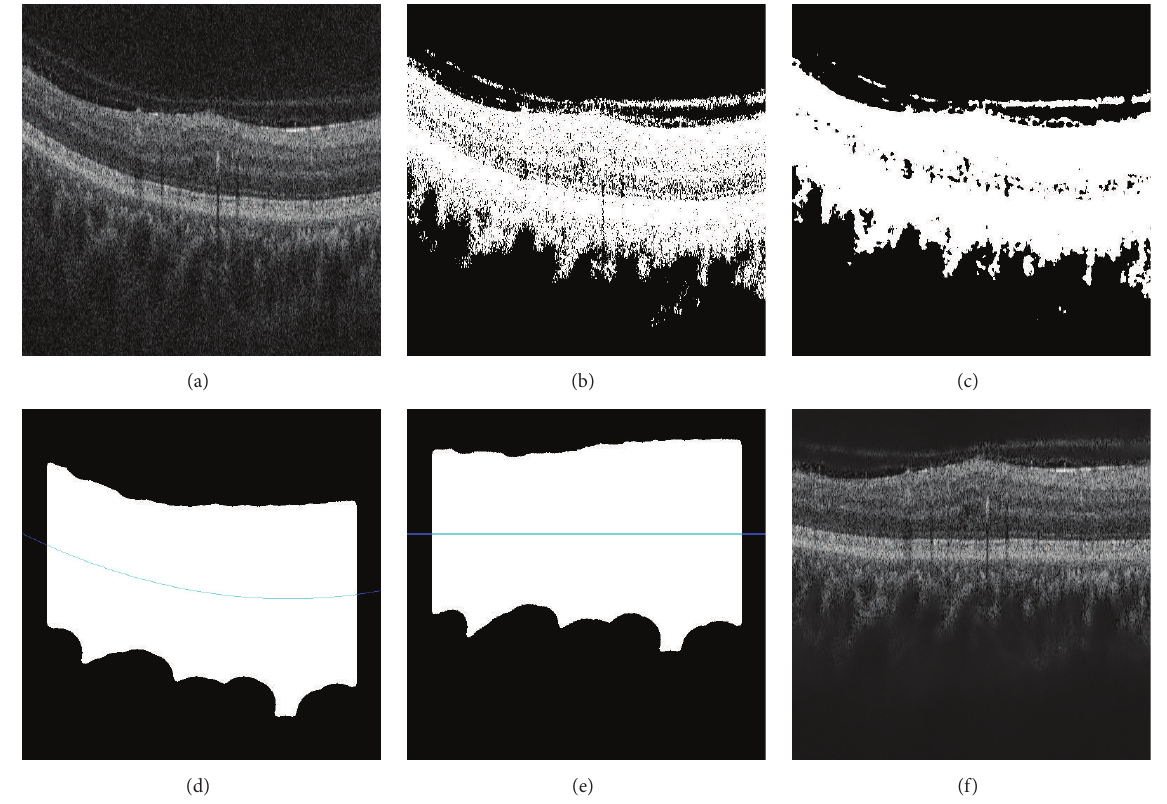
Figure 4: Flattening procedure: (a) original image, (b) thresholding, (c) median filtering, (d) curve fitting, (e) warping, and (f) flatten image.